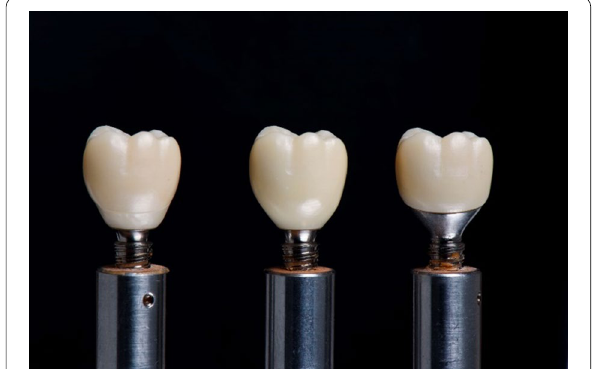
Fig. 2 Hybrid zirconia abutment (left), Straight titanium abutment (middle), Customized titanium abutment